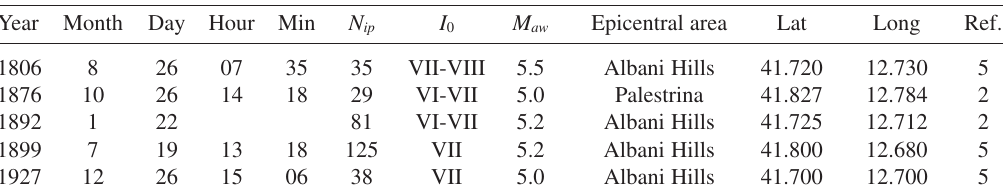
Fig. 5. Distribution of the epicentres and related site intensities of the earthquakes used for the Neapolitan vol- canic district (listed in table III). Symbols as in fig. 2: Ischia (black star), 2 earthquakes for 37 site observations; Vesuvius (white star), 1 earthquake for 48 site observations. Table IV. Dataset of the earthquakes selected for the Albani Hills. M aw , moment magnitude from CPTI Work- ing Group (2004). Source of data: 2) Monachesi and Stucchi (1997); 5) Boschi et al .